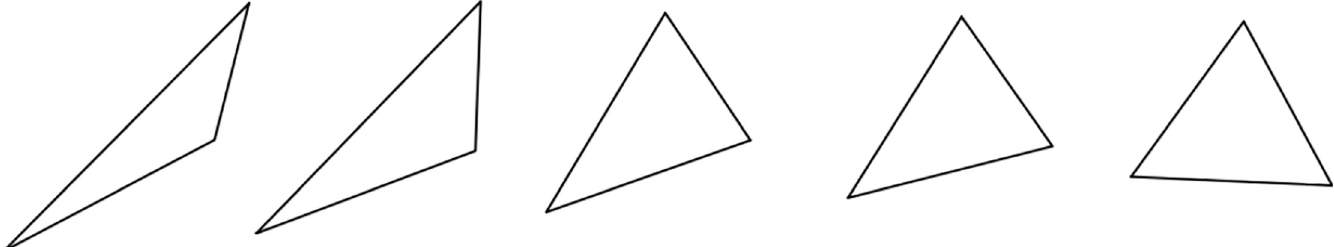
Fig 3. The geometric transformation process of a triangle